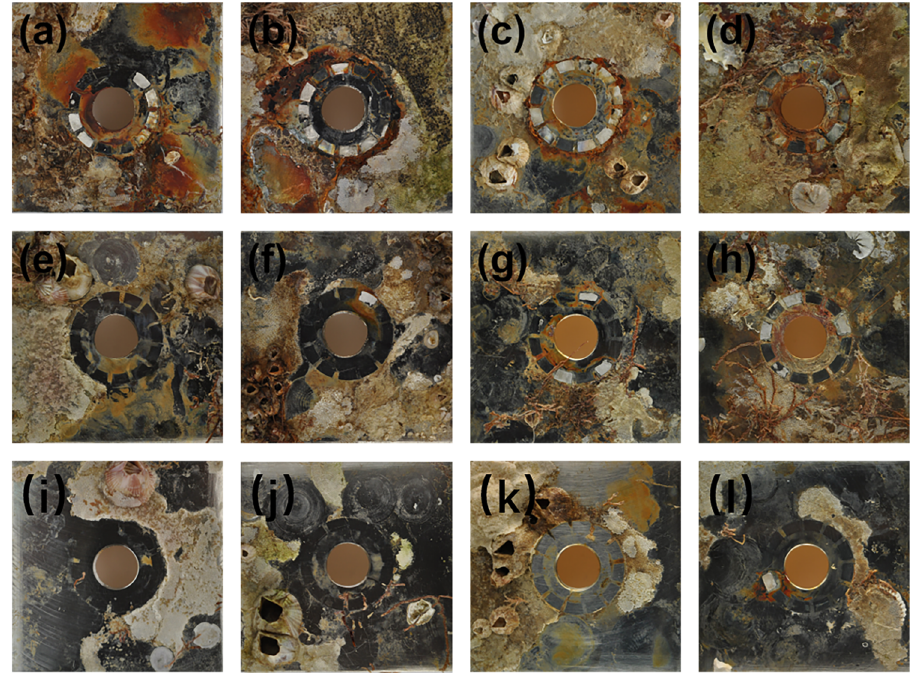
Fig. 1 Macroscopic corrosion morphologies of three stainless steels after being immersed in natural seawater for different time. a – d shows the surface of 316L SS for 6, 12, 24, 36 months. e – h shows the surface of 2205 DSS for 6, 12, 24, 36 months. i – l shows the surface of 2507 SDSS for 6, 12, 24, 36